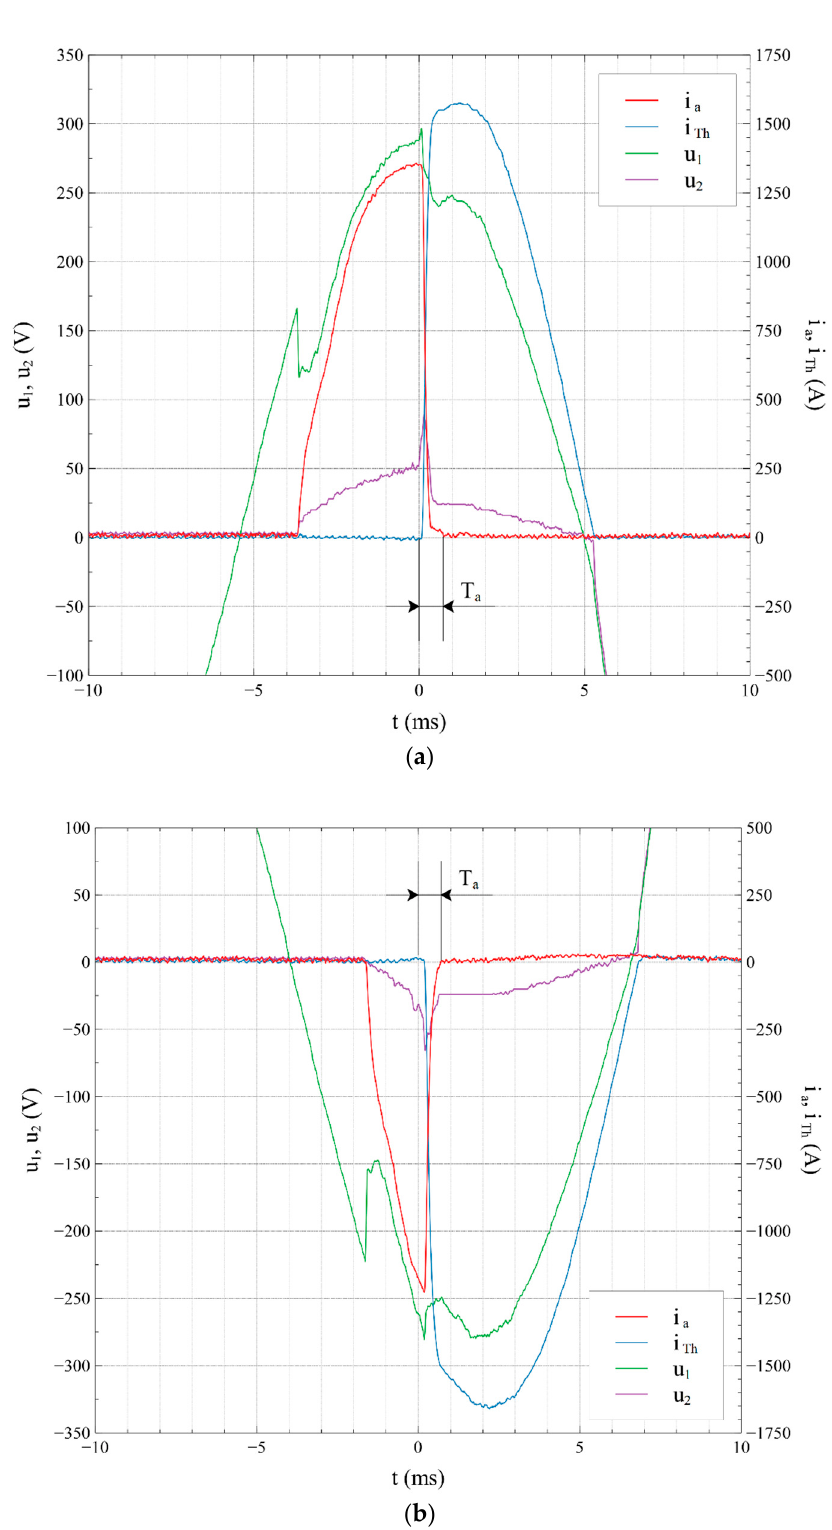
Figure 5. Current waveforms in the load ( i a ) branch and current in the thyristor branch ( i Th ) and supply voltage ( u 1 ) and voltage measured on the arc source electrodes ( u 2 ) in the arc eliminator system: ( a ) Arc eliminator switched on when an electric arc flash was detected for a positive half-wave of flowing current, L R = 0 µH, arc time T a = 0.72 ms; ( b ) Arc eliminator switched on when an electric arc flash was detected for a negative half-wave of flowing current L R = 0 µH, arc time T a = 0.7 ms.